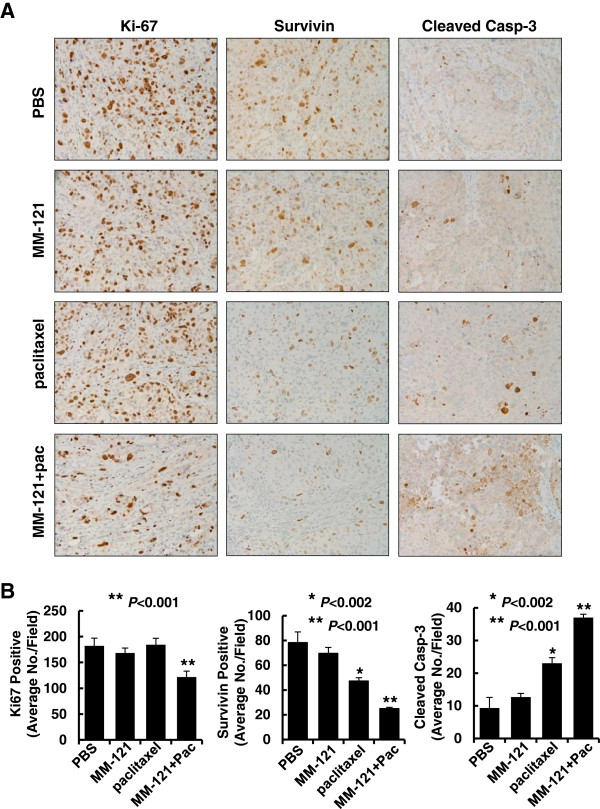
The combination of MM-121 and paclitaxel significantly inhibits tumor cell proliferation, reduces expression of Survivin, and induces apoptosis in an in vivo mouse model. The tumors obtained from the animal studies described above were evaluated by immunohistochemical (IHC) analysis of Ki-67, Survivin, and cleaved caspase-3. (A) Data show the representative images of the immunostainging of Ki-67, Survivin, and cleaved caspase-3. (B) The IHC slides were observed by two independent personnel. The tumor cells with positive staining of Ki-67, Survivin, or cleaved caspase-3 were counted from three randomly selected areas in each slide. The three areas were first identified by scanning the entire slide at × 100 magnification, and then the positive-stained cells were counted at × 200 magnification using an Olympus BX40 microscope. The bar graphs show the average of positive staining cells in each field. Bars represent SD. *P <0.002 versus control or MM-121. **P <0.001 versus control or single-agent treatment.